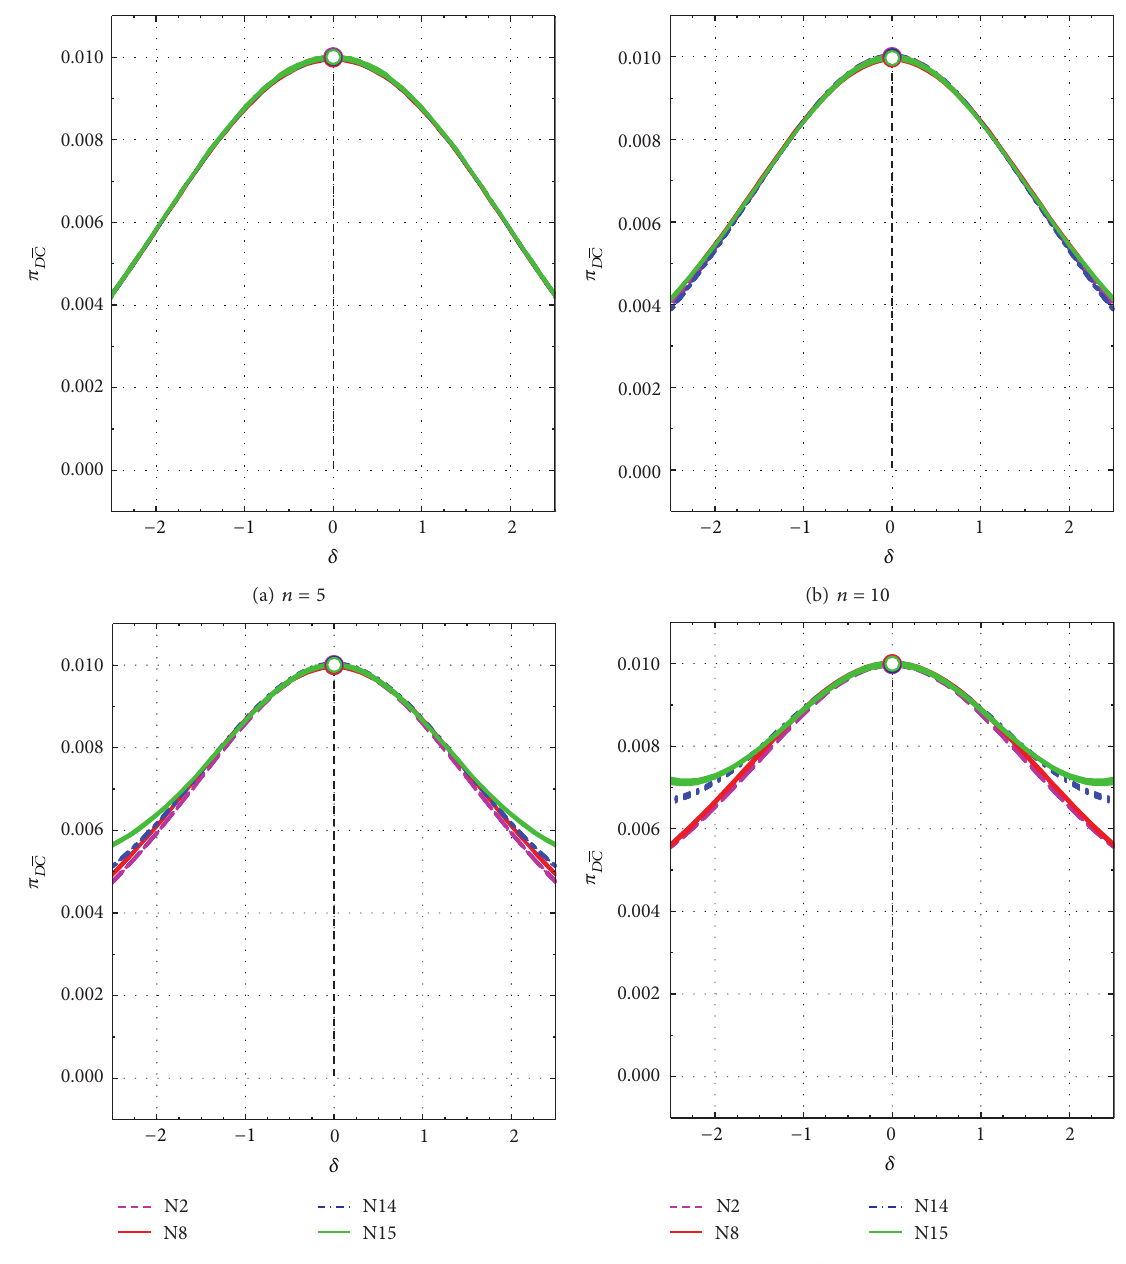
Figure 4: Spurious power probability ( 𝜋 𝐷𝐶 ) as a function of 𝛿 from − 2.5 to +2.5 for all tests N2, N8, N14, and N15. 𝜋 𝐷𝐶 values for uncontaminated samples ( 𝛿 = 0 ) are shown by open circles. (a) 𝑛 = 5 ; (b) 𝑛 = 10 ; (c) 𝑛 = 15 ; and (d) 𝑛 = 20